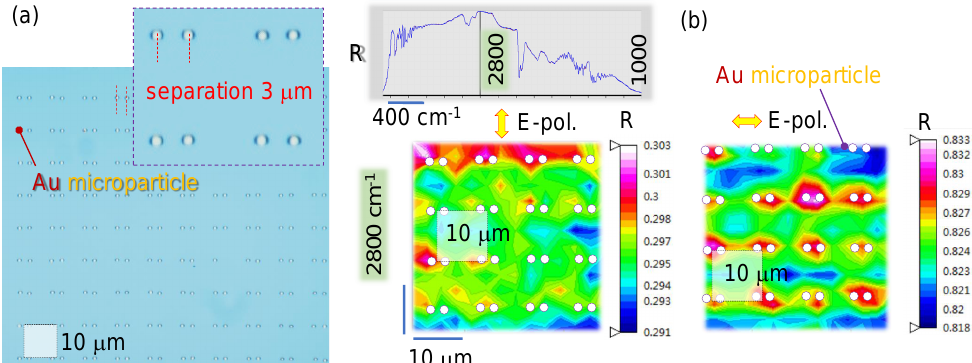
Figure A1. ( a ) Optical image (reflection) of Au microparticles on Si substrate. ( b ) Reflection spec- tral mapping of Au microparticles (pairs) patterned at Λ x , y = 10 µ m array at two perpendicular polarisations; map taken at 2800 cm − 1 or 3.57 µ m or 83.94 THz. Circular markers are locations of Au microparticles of ∼ 0.7 µ m. Au microparticles were LIFT transferred from 50 nm film by using NA = 0.26 objective lens at pulse energy E p = 816 nJ. Separation between Au microparticles 3 µ m. The light source is Australian Synchrotron. The mapping was carried out by MCT detector with a scanning pinhole aperture of 3 µ m. The reference was flat Si